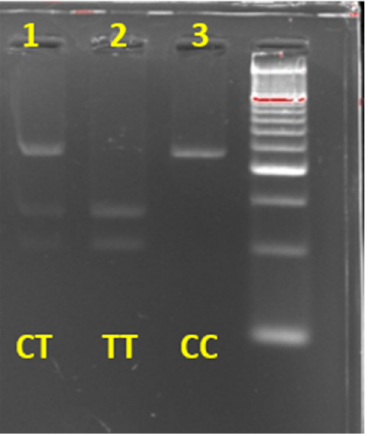
Figure 3. Electrophoretic profiles of genotypes obtained for ACTN3